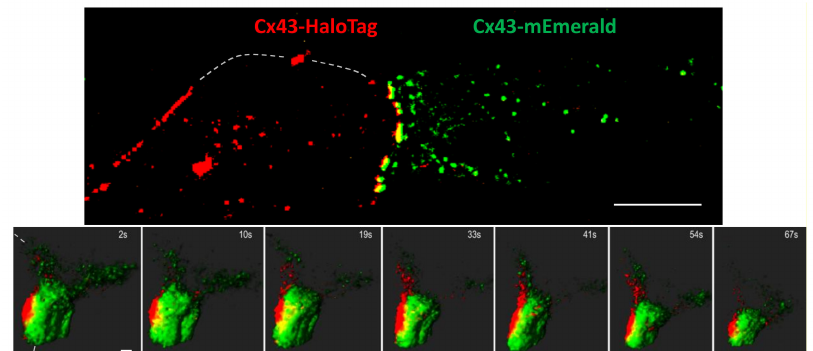
Figure 3. Top panel, LLSM images of BWEM cells expressing Cx43-mEmerald (right cell) mixed with Cx43-HaloTag expressing cells labelled with the red TMR ligand (left cell). Dashed lines indicate approximate plasma membrane positions. Bar is 10 µ m. In lower panels, cells were treated with 25 nM TPA to induce disassembly of a large gap junction. Bar is 0.5 µ m. See Supplementary Video